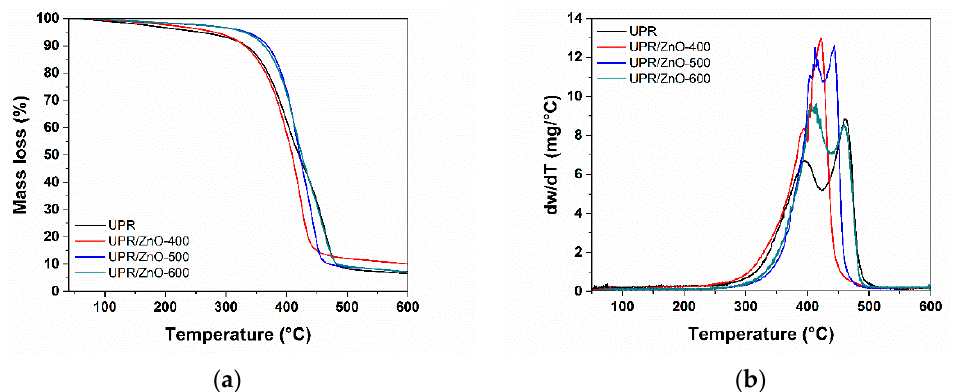
Figure 4. Thermogravimetric plots from UPR and nanocomposites: ( a ) TGA and ( b ) derivative thermogravimetric (DTG). Table 1. Data obtained from the thermogravimetric curves.